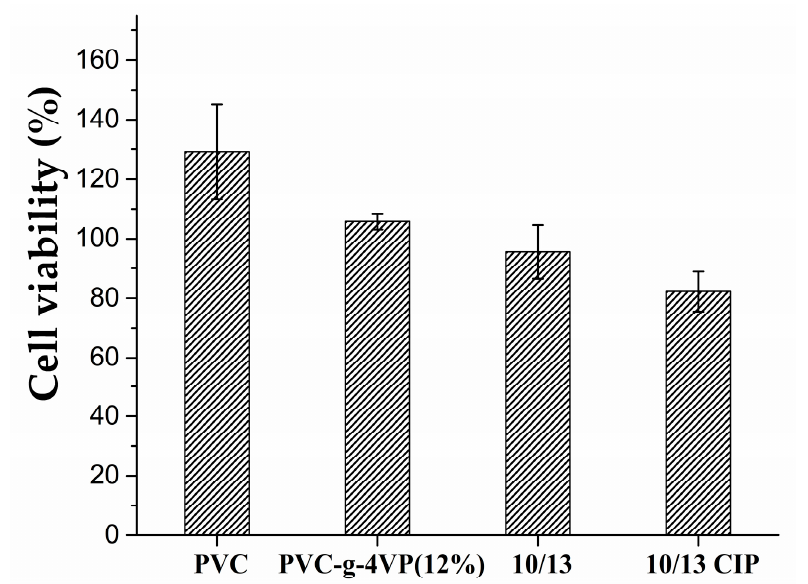
Figure 9. Cell viability result using BALB/3T3 murine embryonic fibroblasts and MIT assay. Reported: mean ± standard error of the mean, n = 3.